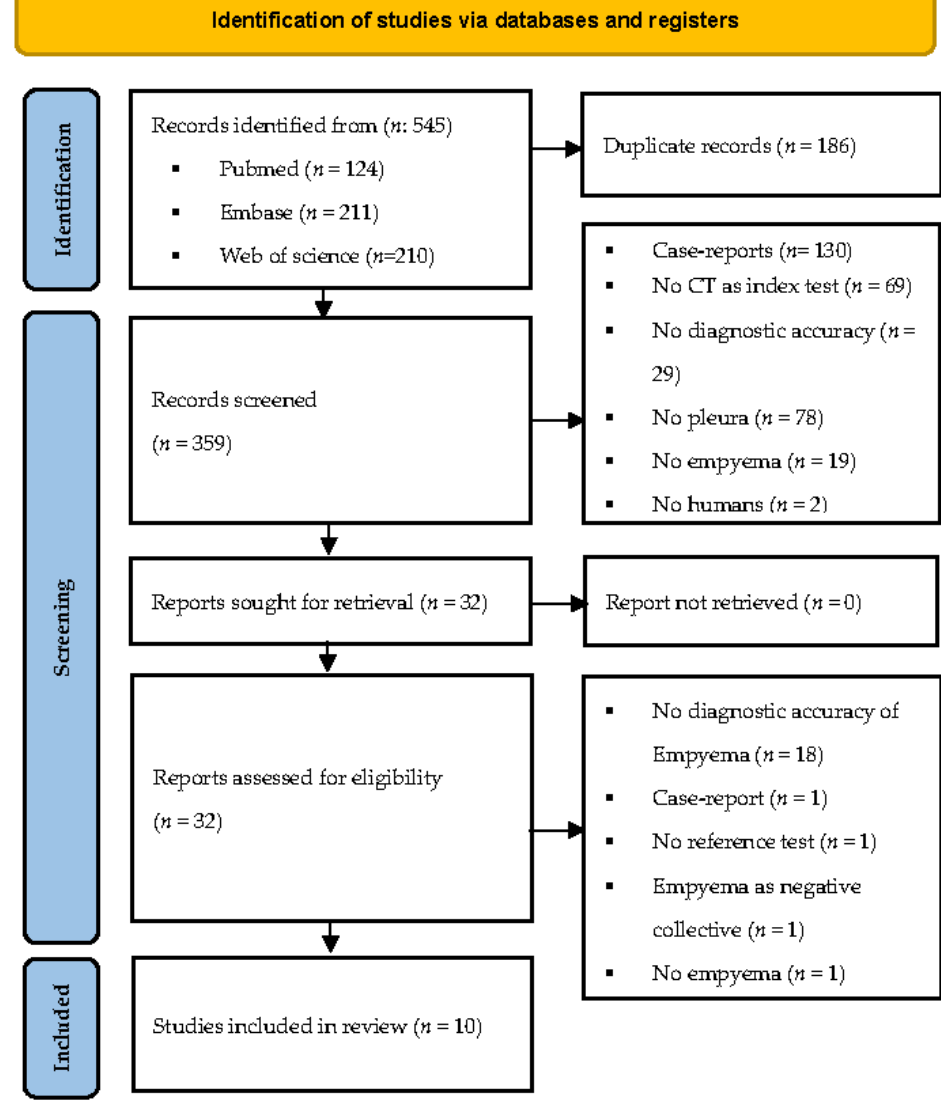
Figure 1. Study flow chart according to PRISMA [45].